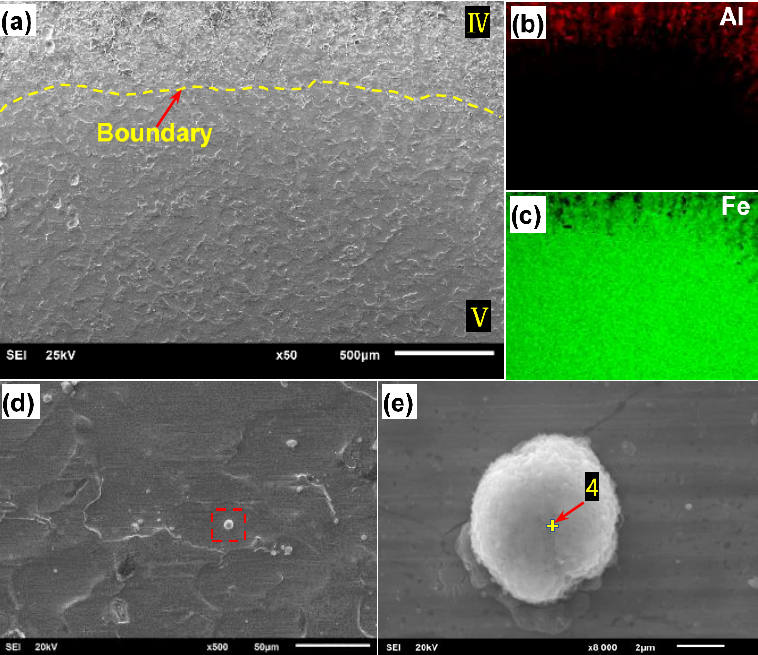
Figure 6. ( a ) Inner boundary area between layers IV and V; ( b , c ) EDS elemental maps of ( a ); ( d ) a magnified image at a location in layer V; ( e ) a further magnified image of the red-boxed area in ( d ), showing a splashed ball-like particle.